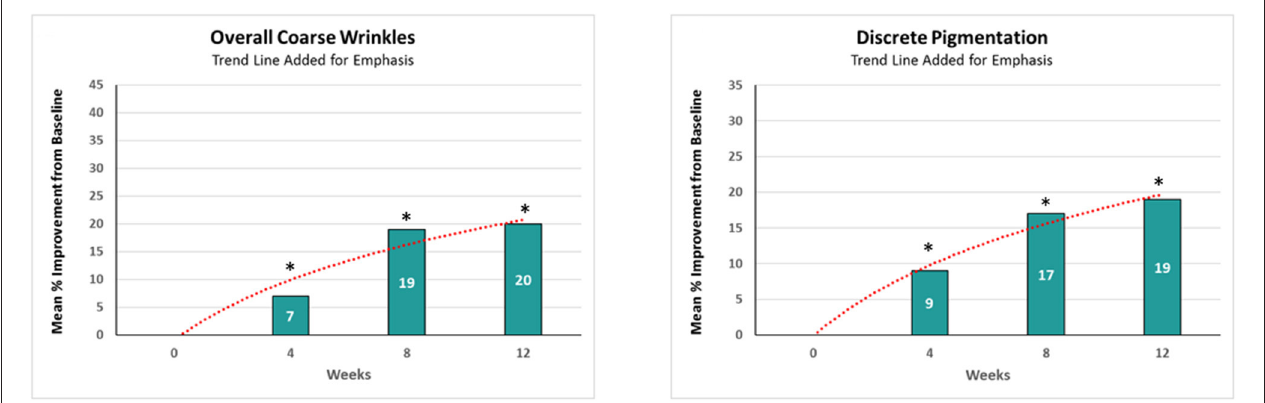
FIGURE 1 | The effect of retinol on clinical efficacy rate of improvements. A significant ( p < 0.05) improvement in both coarse wrinkles and discrete pigmentation was observed as early as 4 weeks, but the rate of improvement achieved over a given time interval decreased as the study progressed. *Means p < 0.05 or statistically significant